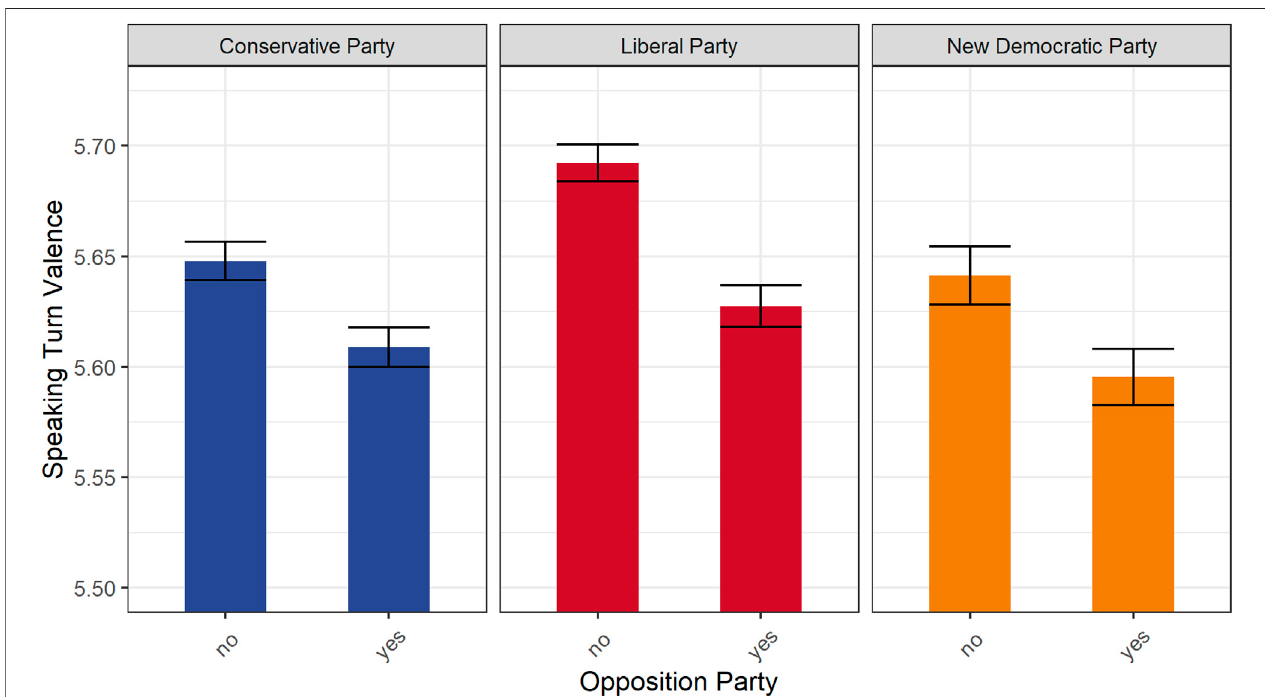
FIGURE 2 | Speaking turn valence for the CPC, Lib, and NDP. For each party, two bars are shown. This fi rst shows average speaking turn valence when the party was not the of fi cial opposition. The second shows valence when the party did have the role of of fi cial opposition party. Values are based on the estimates of a linear